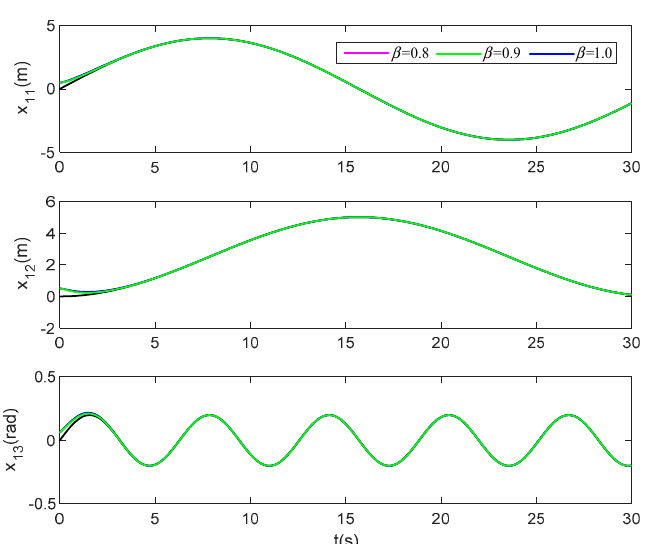
Figure 12. Pose tracking of the vessel with different orders. Figure 16 shows the control force change curves under the action of three fractional orders. It can be seen that when β = 0.8, β = 0.9 and β = 1.0, the control force curves of three-degree-of-freedom do not exceed their respective constraints, that is, they satisfy τ 1 ∈ [ − 50 N, 50 N ] τ 2 ∈ [ − 30 N, 30 N ] and τ 3 ∈ [ − 10 Nm, 10 Nm ] . However, when β = 0.9, the decreasing trend of the control force is obviously faster than β = 0.8 and β = 1.0, indicating that the fractional disturbance observer can better compensate the system uncertainties when β =